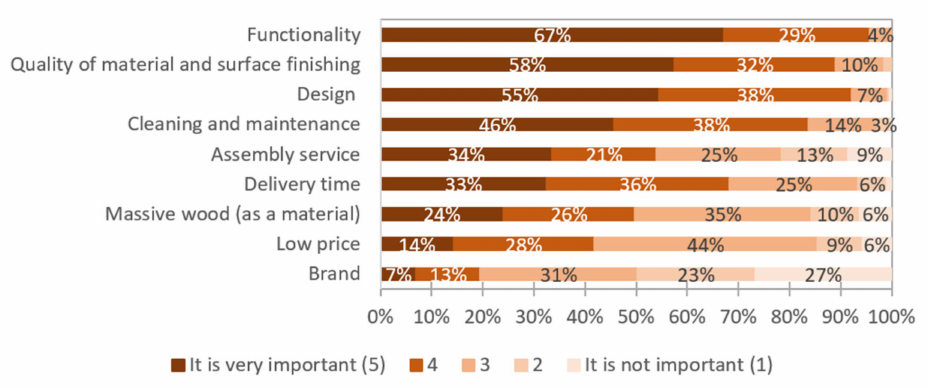
Figure 2. Consumer preferences for furniture attributes ( N = 400).